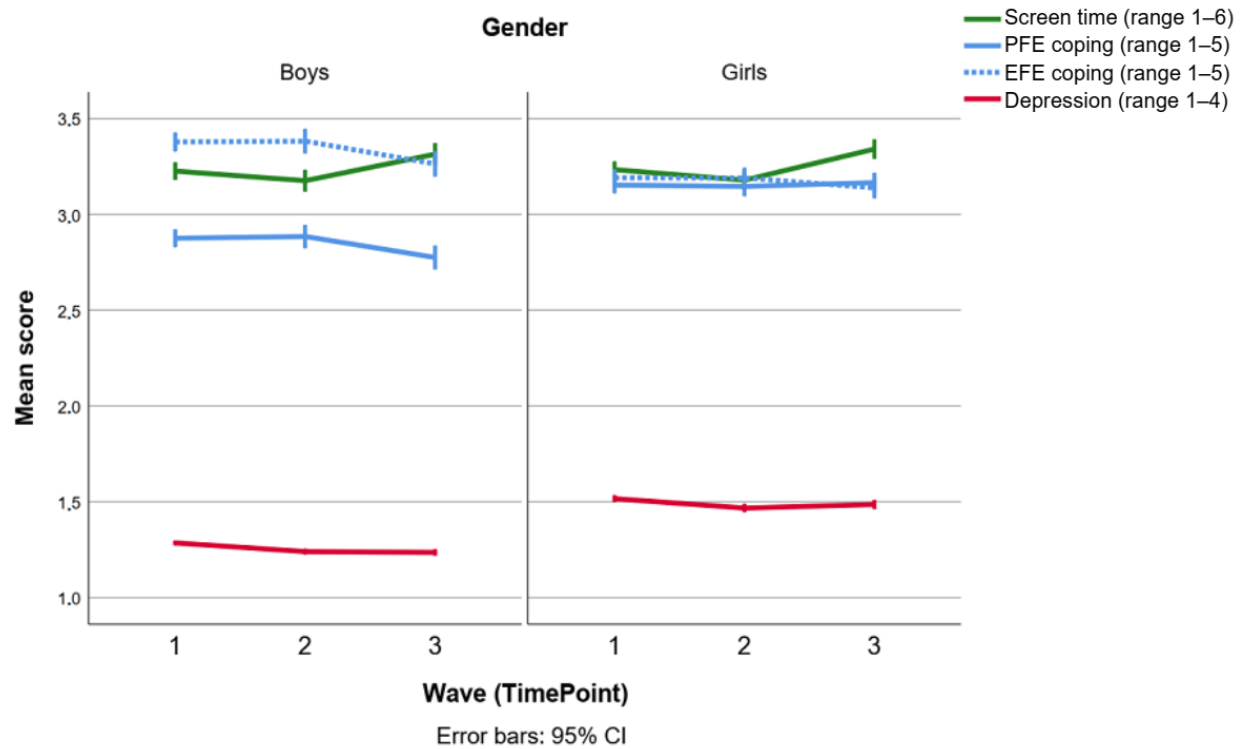
Figure 2. Observed mean scores and 95% confidence intervals for the four key variables, separately for each wave or timepoint (1 = baseline; 2 = three months; 3 = twelve months) and separately for boys ( n = 2431) and girls ( n = 2362). Note that problem-focused engagement (PFE) and emotion-focused engagement (EFE) coping scales are reversed such that higher scores indicate less coping (i.e., an alleged “risk factor”).